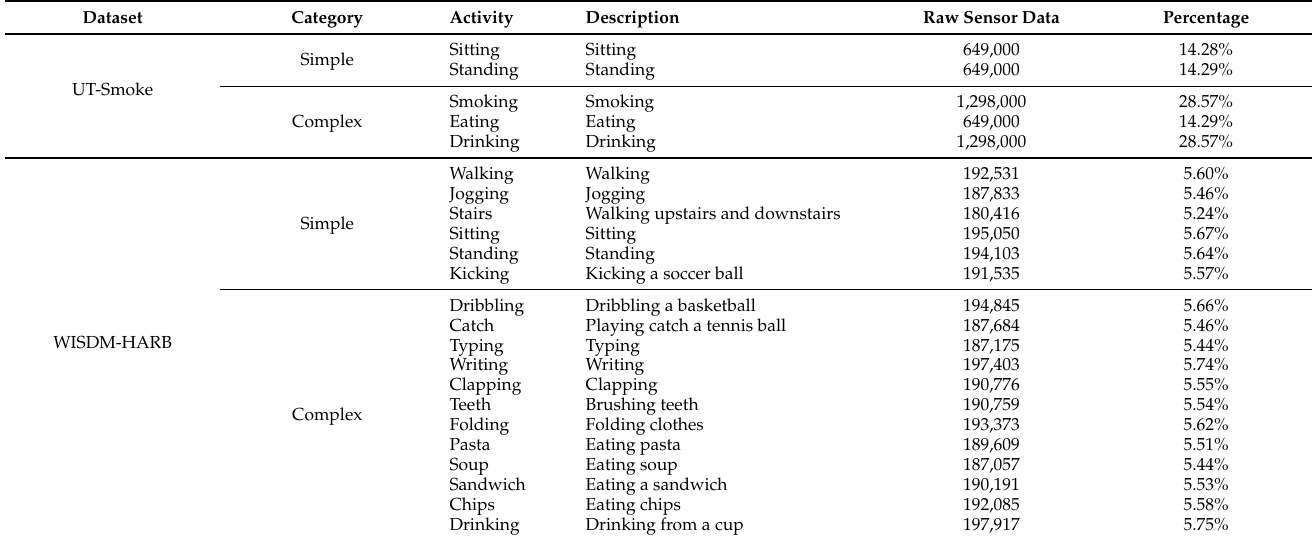
Table 2. Characteristics of the selected activity-based